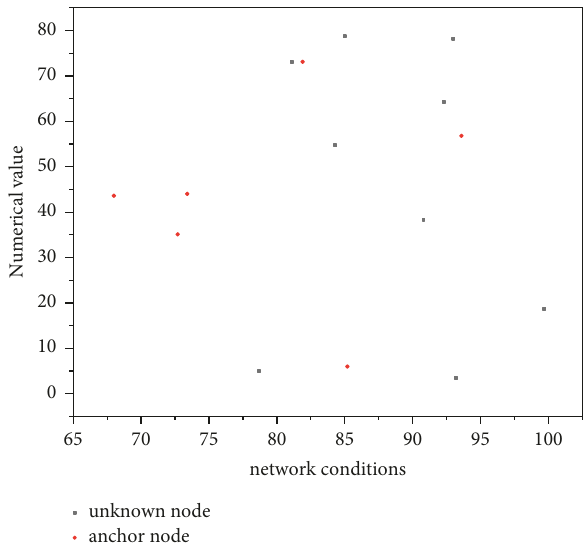
Figure 8: Network distribution of unknown nodes and anchor